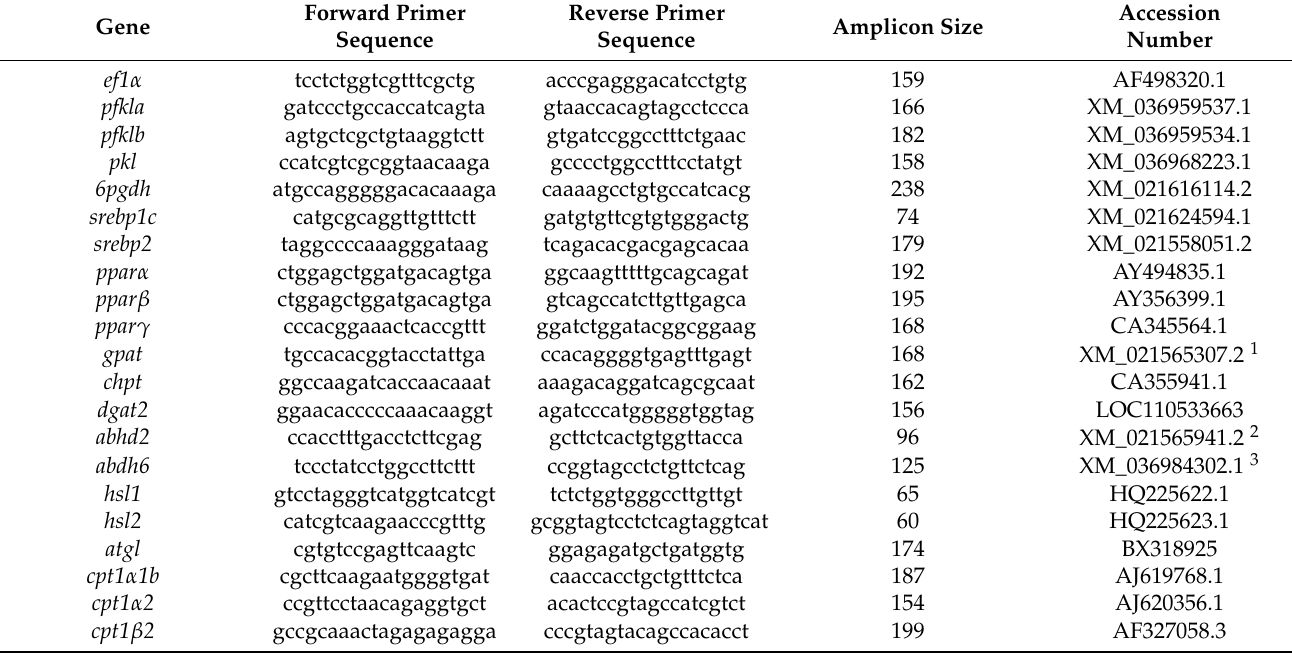
Table 2. PCR primers used to assay gene expression by real-time quantitative polymerase chain